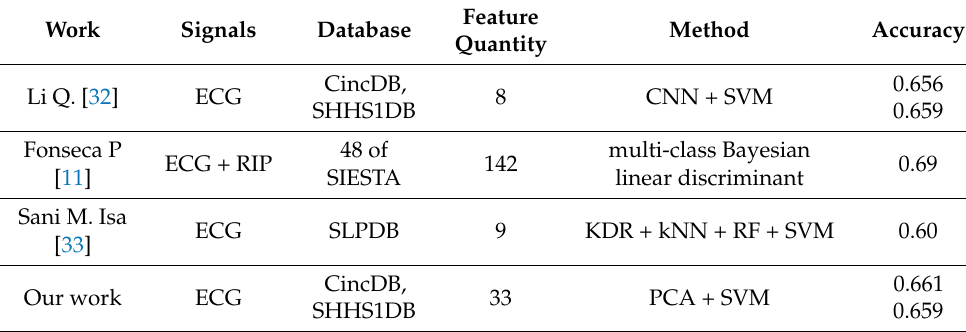
Table 8. Comparison with similar works (four classes).